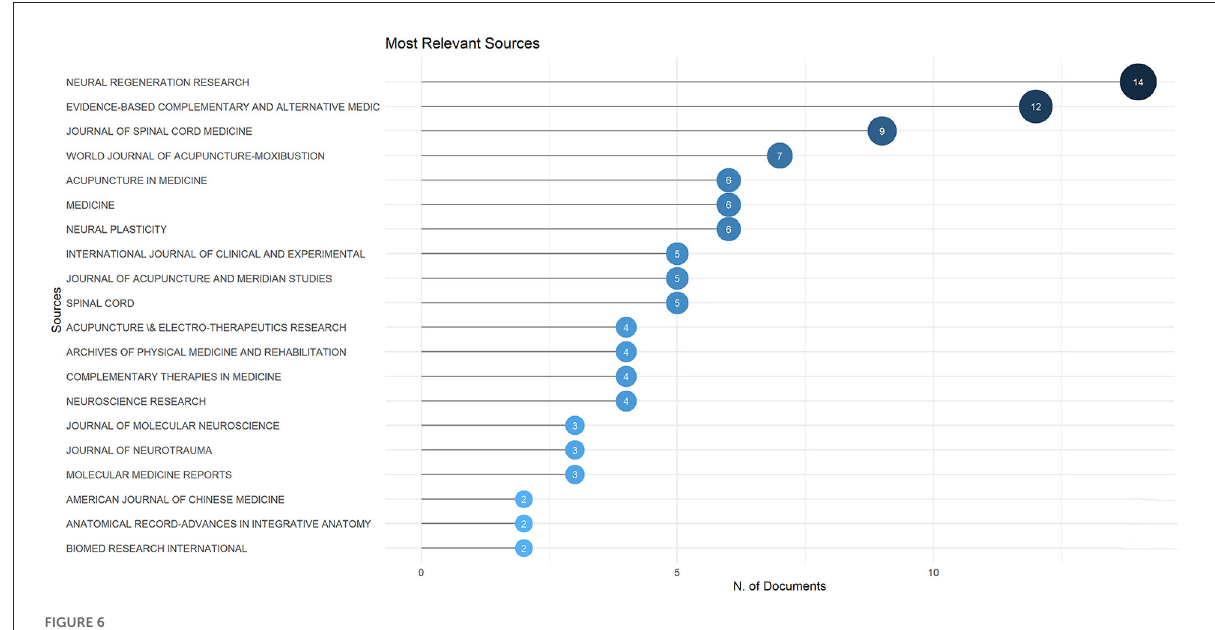
FIGURE6 The most relevant sources in the field of acupuncture for SCI.